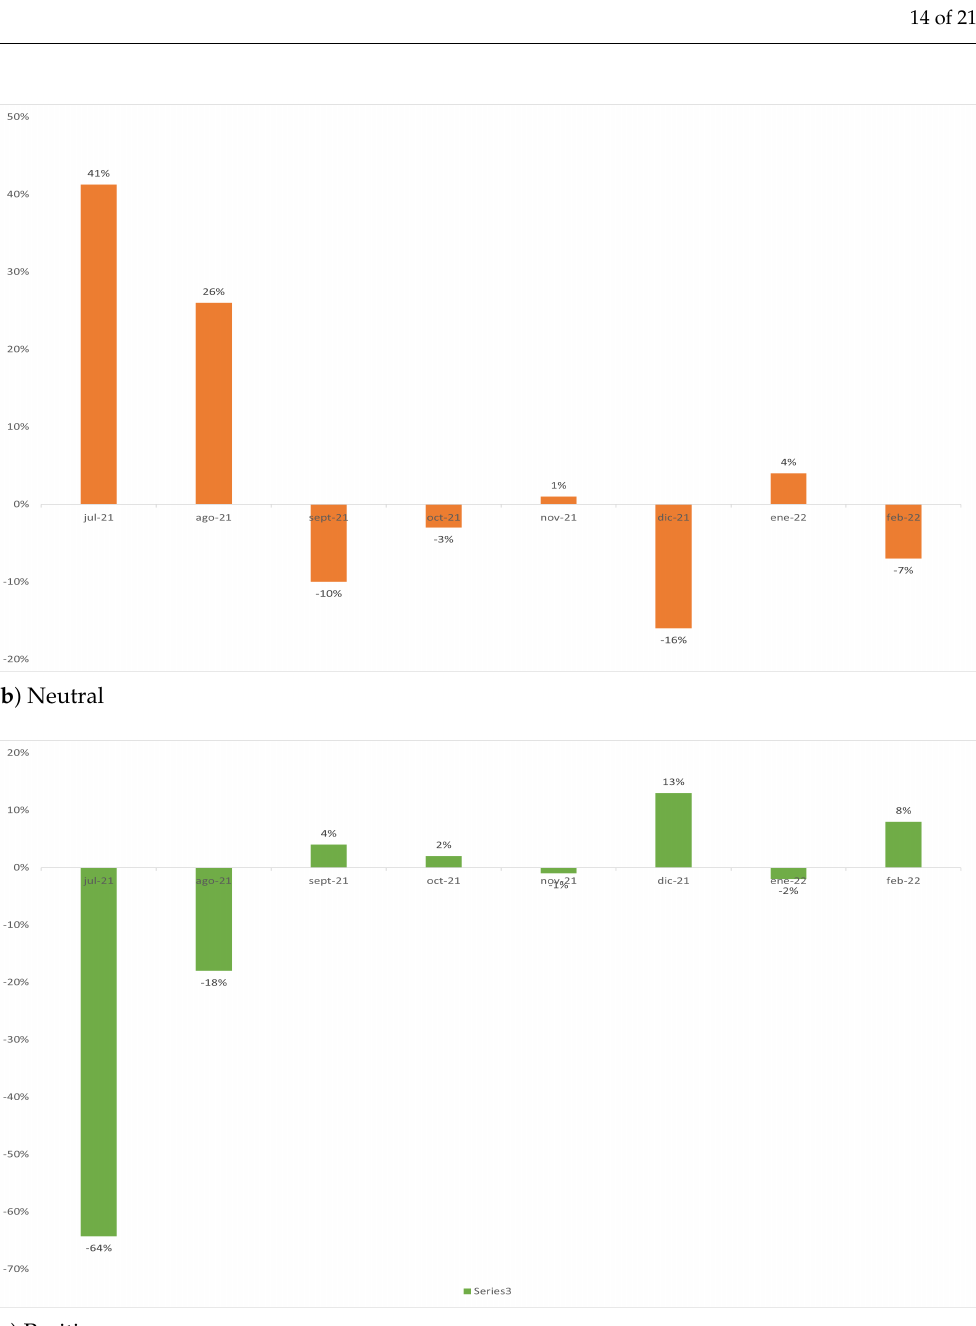
Figure 11. Percentage change in negative, neutral, and positive sentiment over time. Media